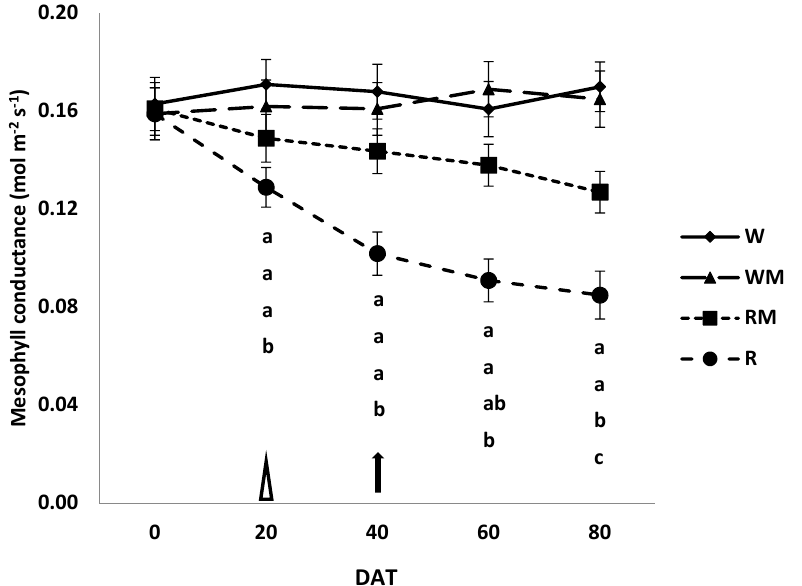
Figure 5. Changes in mesophyll conductance (mol m − 2 s − 1 ) of spearmint exposed to the following treatments: R—rainfed without straw mulch, RM—rainfed with straw mulch, W—well-watered control plants and WM—well-watered with straw mulch. Measurements were performed 0, 20, 40, 60 and 80 days after the onset of the treatments (DAT). Vertical bars represent ± SE of the mean ( n = 5). Bars with different letters indicate significant differences among treatments in the given DAT at p ≤ 0.05. Triangle at 20 DAT indicate the early bloom and arrow at 40 DAT indicate the full bloom, in overall treatments.